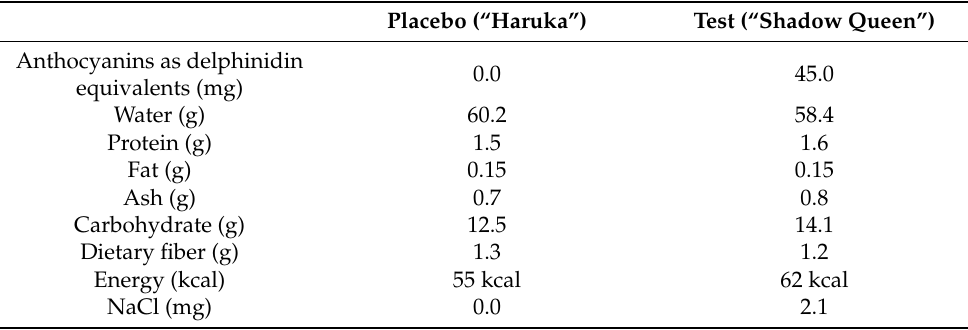
Table 1. Nutritional and functional components in test potatoes (75 g/day). Placebo (“Haruka”) Test (“Shadow